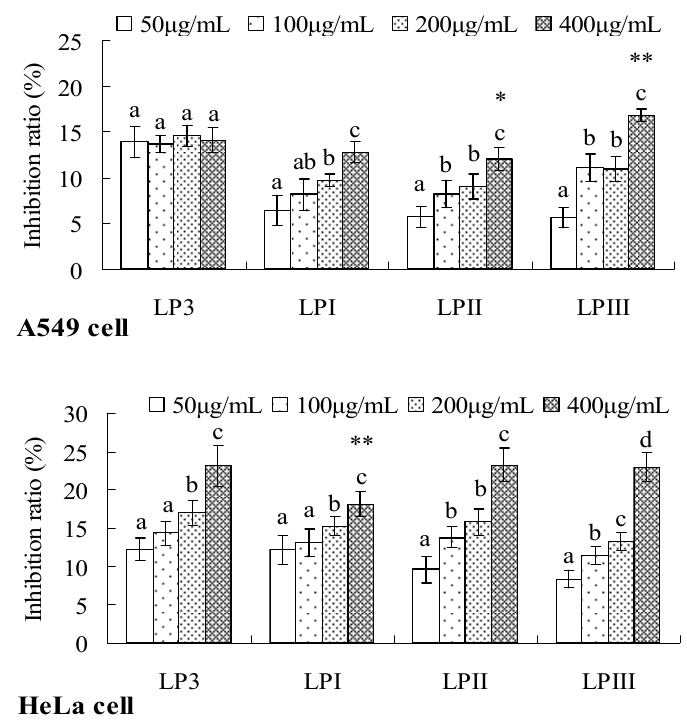
Figure 6. Inhibitory effects of longan polysaccharides on tumor cells in vitro . LPI–III were the fractions isolated from LP3. The cell proliferation was detected using a modified methylene blue method. Column expressed values were significantly different if marked with different letters ( p < 0.05). At 400 µg/mL, the experimental value which showed significant difference from that of LP3 treated group was marked with * ( p < 0.05) or ** ( p <